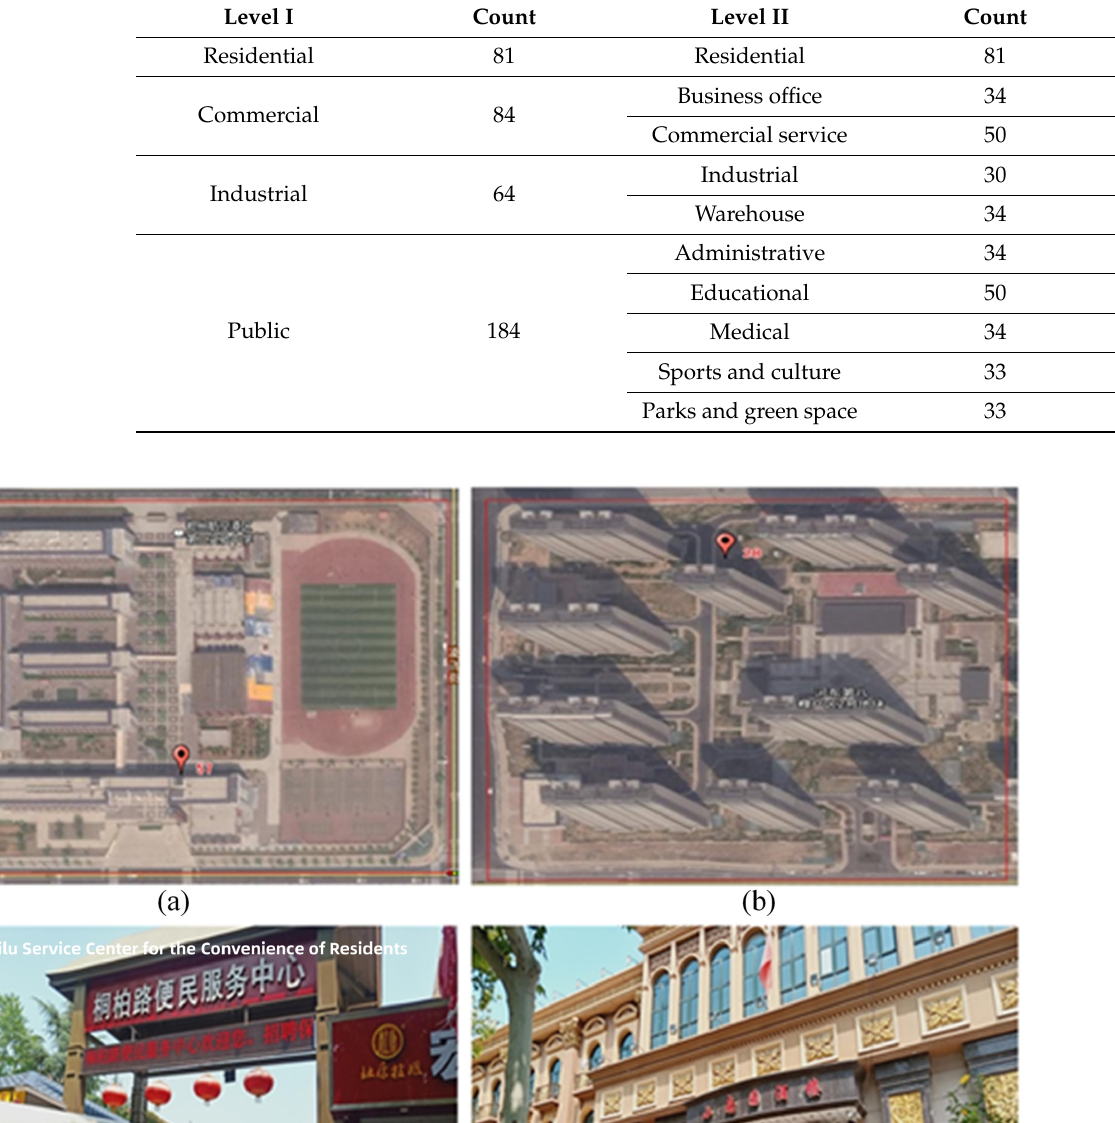
Table 2. Total sample size by feature type.